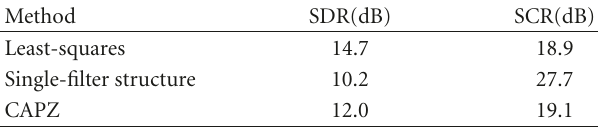
Table 5: Crosstalk cancellation performance in the asymmetric case for the three methods when the inverse filter length equals